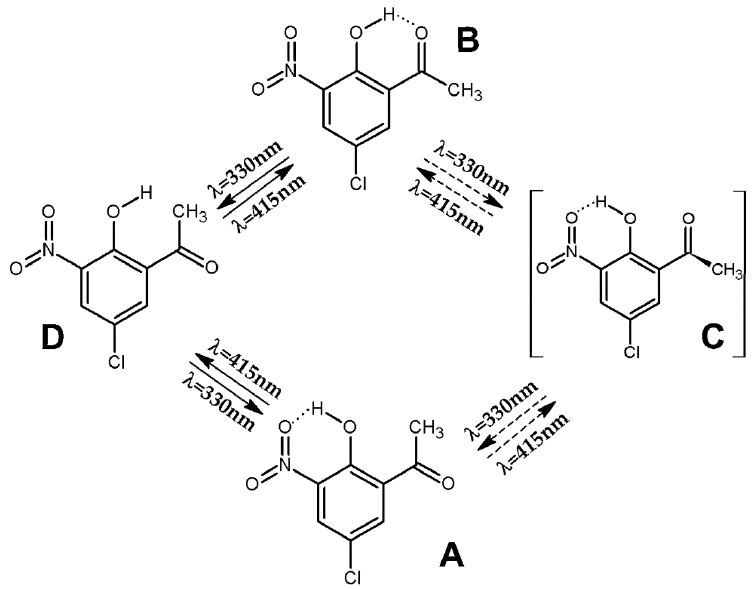
Figure 3. Diagram of photoisomerization processes in 5-chloro-3-nitro-2-hydroxyacetophenone (CNK) upon irradiation at 330 and 415 nm.